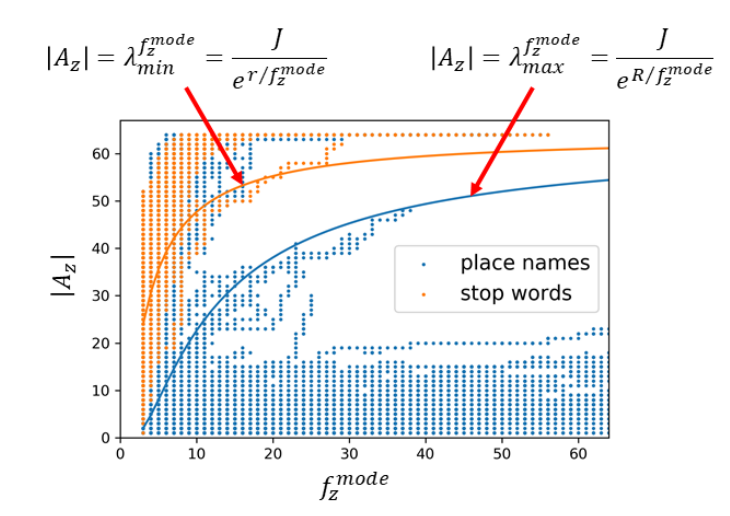
Figure 10. Relations between the area-based maximum frequency f mode z ( f mode z ≥ θ (= 3 )) and the number of areas | A z | for place names and stop